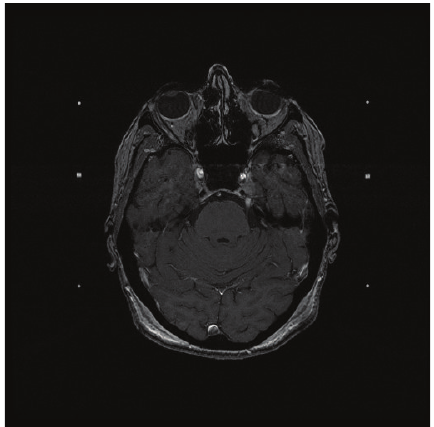
Figure 1: Axial T1 postgadolinium enhanced MRI showing the lesion of the left trigeminal nerve at the time of its original diagnosis as trigeminal schwannoma.